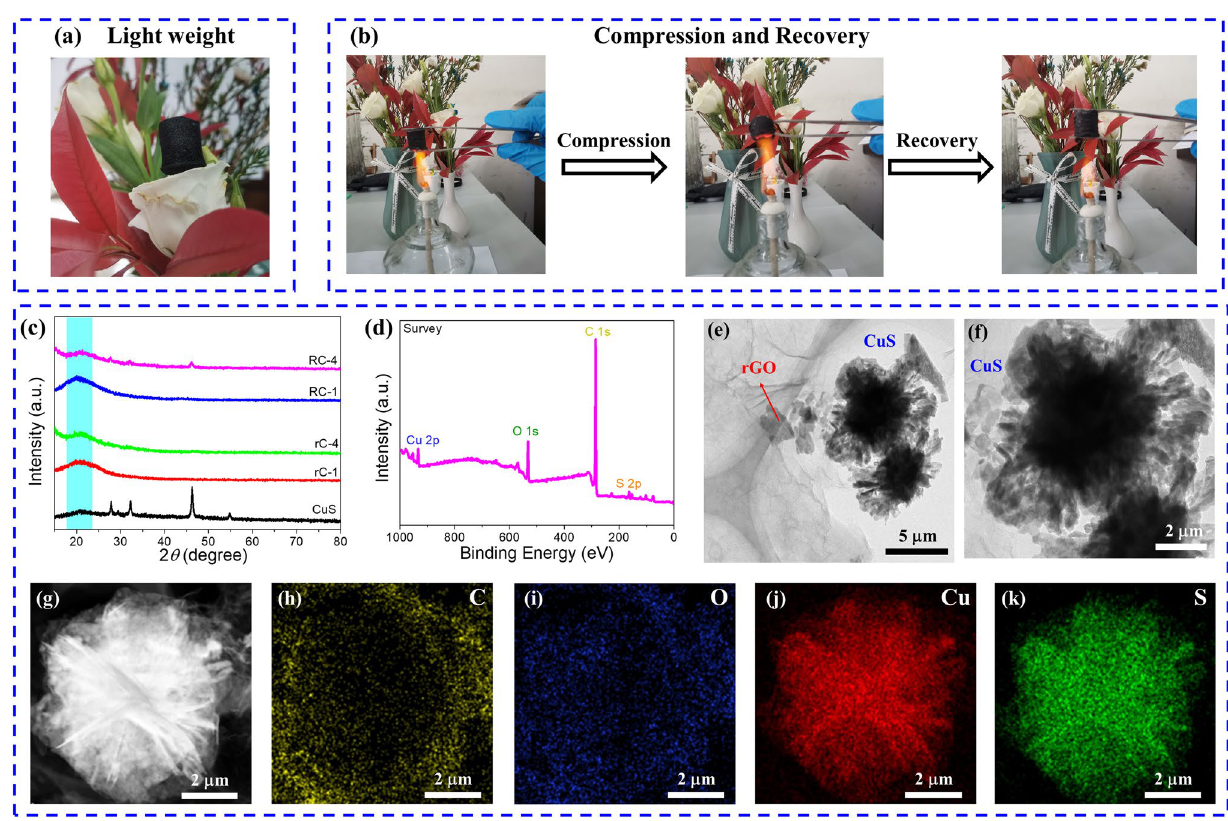
Fig. 2 CuS@rGO aerogel characteristics of a light weight, b compression and recovery. c XRD patterns of CuS, rGO, rC-4, RGO and RC-4. d XPS full spectrum of rC-4. e–f TEM images, and g–k EDS mapping